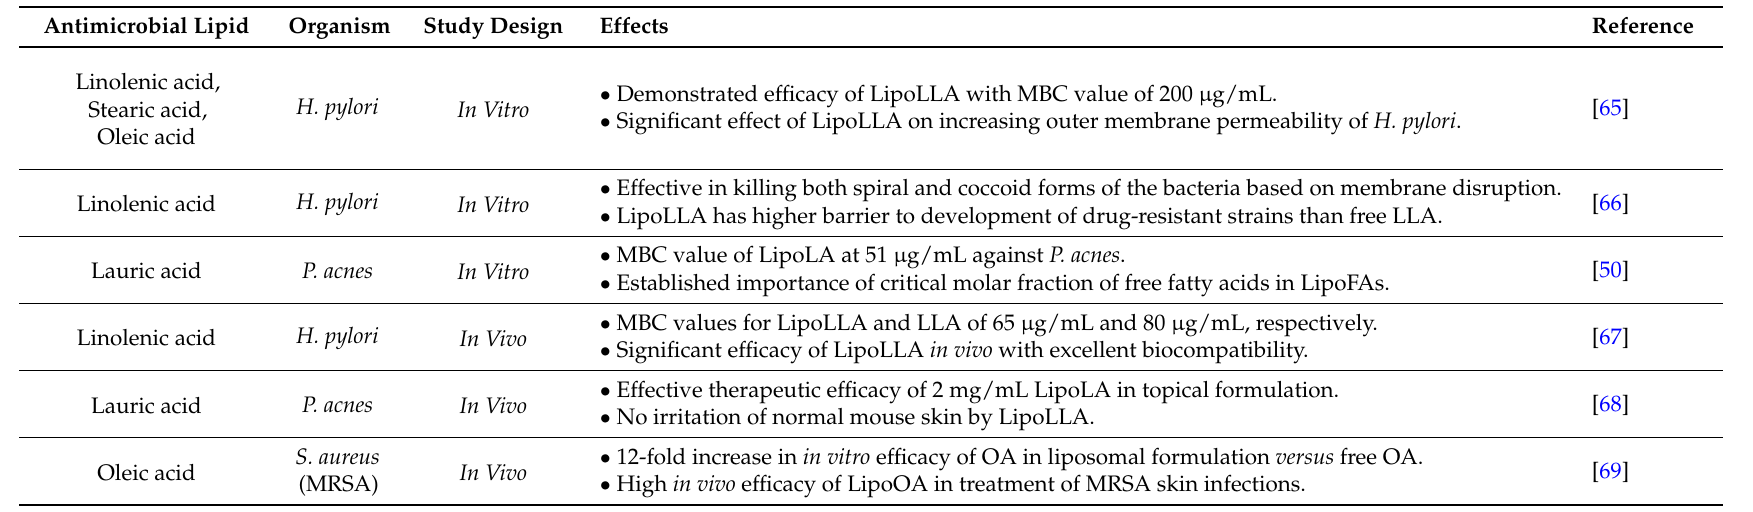
Table 2. Past studies involving antibacterial properties of liposomal fatty